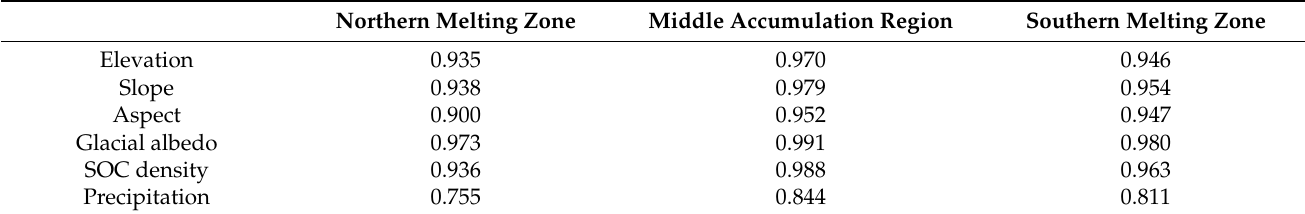
Table 2. Grey correlation factors for melting and accumulation zones. Northern Melting Zone Middle Accumulation Region Southern Melting